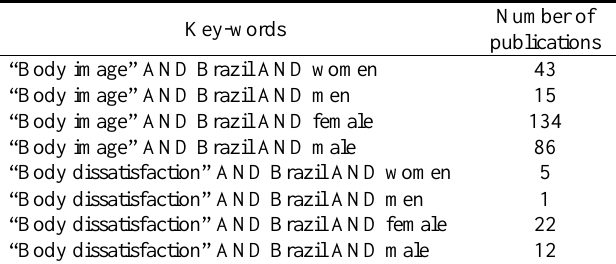
Table 1. Number of paper published and indexed in